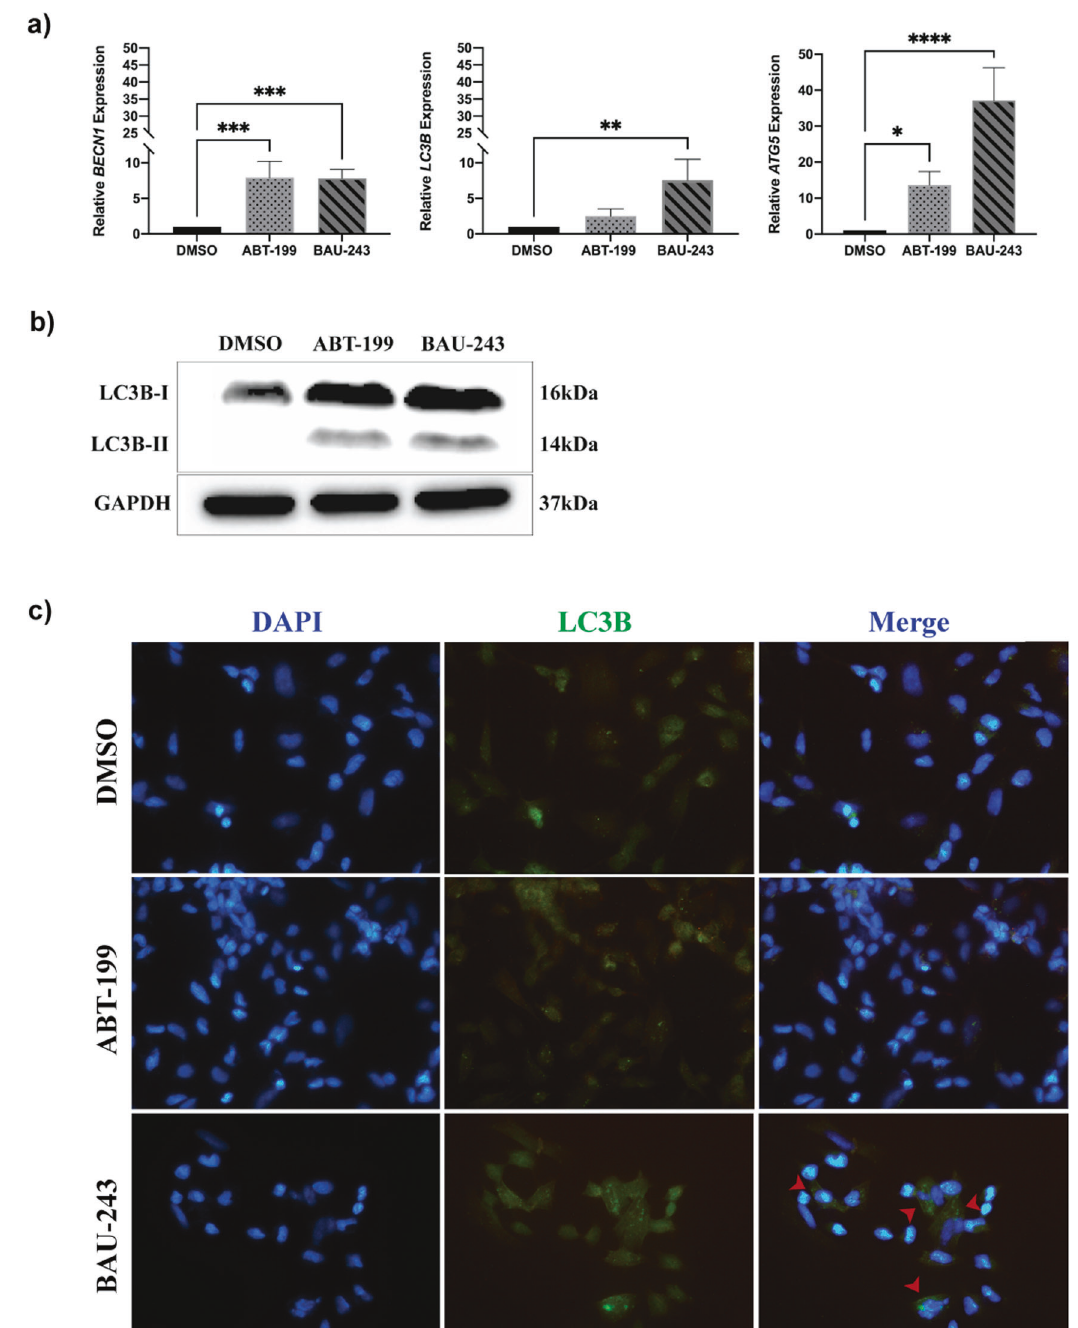
Fig. 5 BAU-243 treatment induced autophagic cell death. a Quantitative RT-PCR of BECN1, MAP1LC3B , and ATG5 of DMSO (0.1%), ABT-199 (10 µM), and BAU-243 (20 µM) treated A172 cells. Cq values are normalized to GAPDH expression, and 2 -ddct values were calculated ( n = 4). b Western blotting of LC3B. 20 µg protein per lane was loaded. GAPDH was used as a control. c Immunocytochemistry fl uorescence microscopy images (40X) of DMSO (0.1%), ABT-199 (10 µM), and 243 (20 µM) treated SHSY-5Y cells. DAPI is represented with blue and LC3B is represented with green. Red arrows indicate autophagosomes. Data are expressed as mean ± SD. Statistical analysis was performed with ordinary one-way ANOVA, together using Dunnett ’ s multiple comparisons test. * p < 0.05, ** p < 0.01, *** p < 0.001, **** p < 0.0001. experimental data suggested that BAU-243 disrupted the interaction between Beclin 1:Bcl-2. Therefore, we carried out MD simulations for Bcl-2 in complex with Beclin 1 BH3 domain to compared to our previous study. We performed a re-docking determine critical Bcl-2 residues that might be interacting with analysis for co-crystalized ABT-199 by the QPLD approach and the BH3 domain of Beclin 1. We sought to detect whether BAU- revealed that the obtained pose was similar to the crystal 243 can also interact with these critical residues of Bcl-2 and docking pose (RMSD between two poses is 1.12 Å). Our Cell Death Discovery (2022)